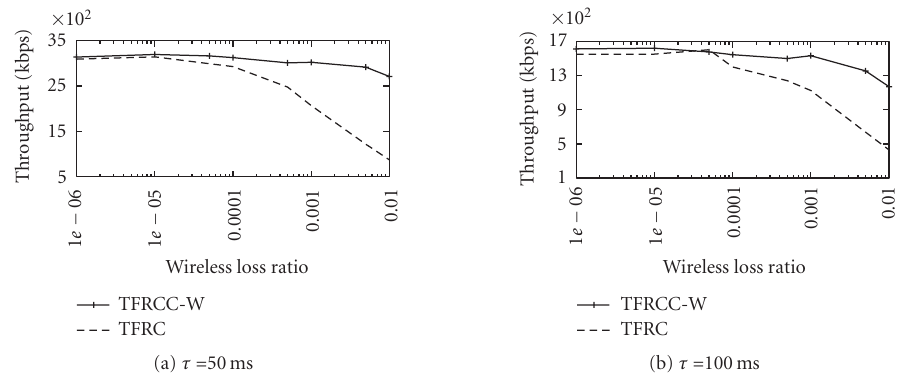
Figure 5: Performance comparison between TFRCC-W and TFRC in the wireless scenario.